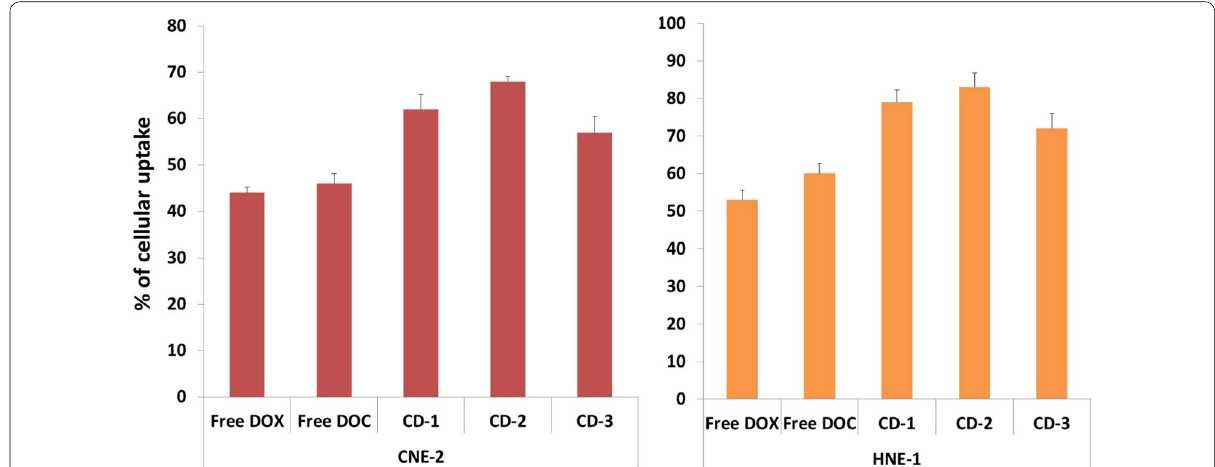
Fig. 10 Cellular uptake of free docetaxel, doxorubicin, CD‑1, CD‑2 and CD‑3. Reduced uptake of drugs and NPs by CNE‑2 cells due to absence of folate